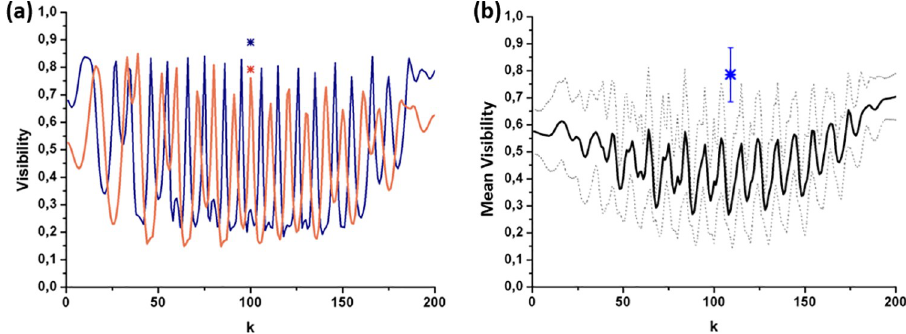
Fig 6. Visibility values calculated from DoP images corresponding to 200 different input polarizations (k parameter). (a) Orange curve and blue curve provide the visibility related to the orange and blue segments in Fig 3A, respectively; and (b) Mean visibility (black curve) as a function of the input polarization, calculated from 10 different segments (orange, blue and 8 green lines in Fig 3A) arbitrarily selected along the leaf. The corresponding standard deviations values are given by the upper and lower dashed black